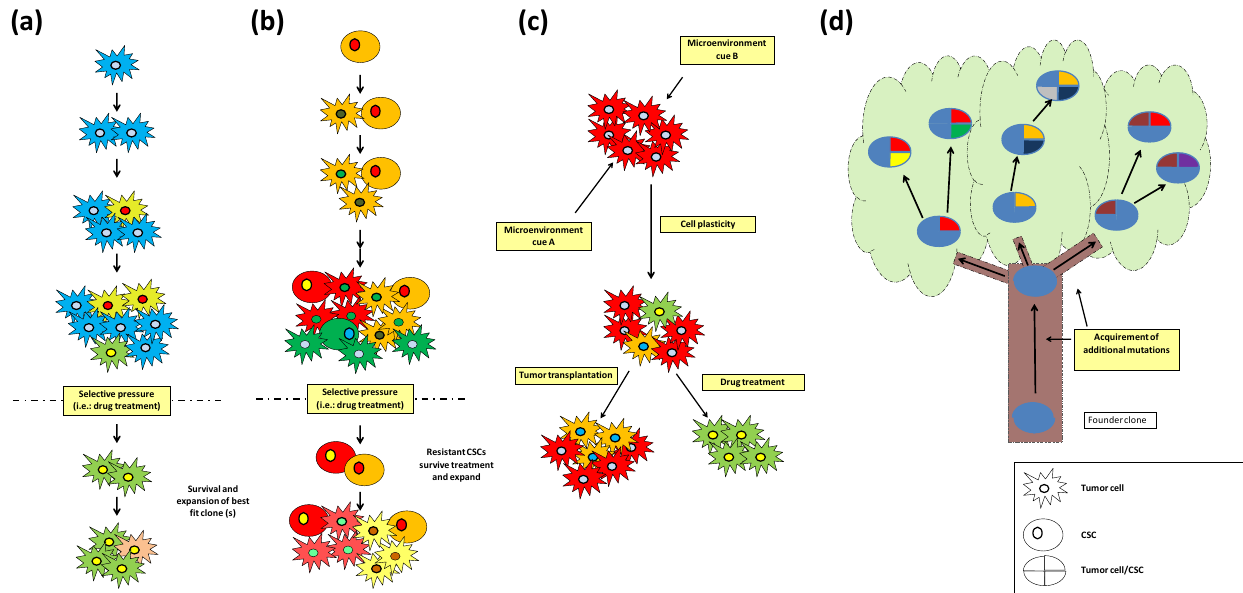
Figure 1. Models for the origin of intra-tumor heterogeneity. ( a ) Clonal evolution: tumor cells divide and acquire mutations, upon a selective pressure the most fit clone (s) will survive and cause tumor relapse; ( b ) CSC model: CSCs divide asymmetrically and generate CSCs and more differentiated tumor cells that can acquire mutations. Upon treatment, resistant CSCs will survive and cause tumor relapse; ( c ) Heterogeneity can be generated by cell plasticity in response to microenvironment cues that mainly through epigenetic mechanisms generate cells with different tumorigenic properties as in example tumor initiation capacity or drug resistance; ( d ) Branched tree model: Mutations shared by all tumor cells proceed from the founder clone which is depicted as the trunk of the tree. The branches are composed by tumor cells that acquire mutations present only in a subset of the tumor